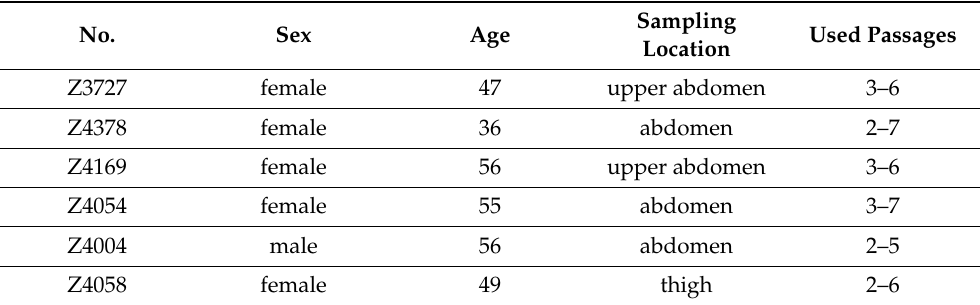
Table 1. List of donors from which adipose-derived stem cells were isolated. Sex, age, sampling location, and the passages used in all experiments are given. No. Sex Age